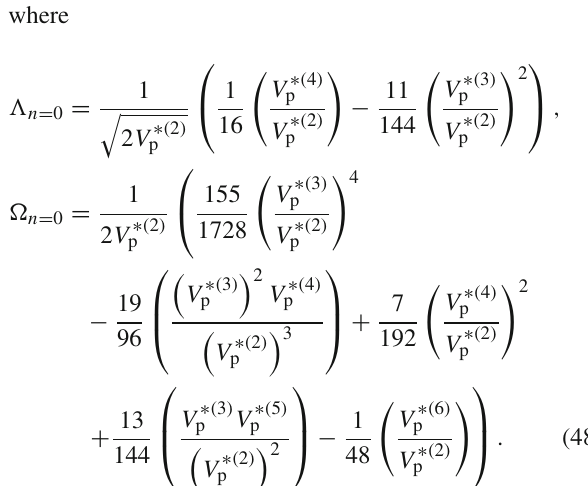
Fig. 2 β of the dominant mode of dS spacetime with (cid:5) = 1